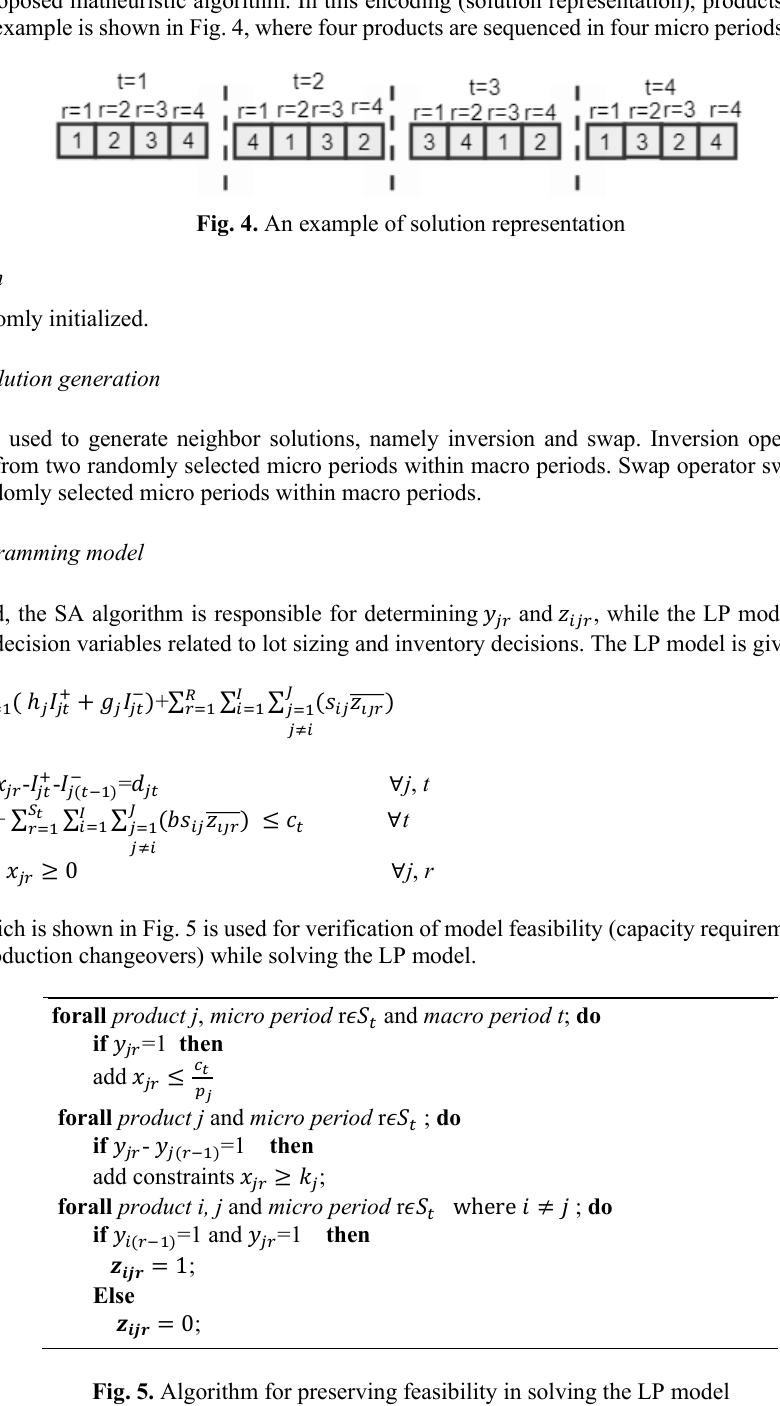
Fig. 5. Algorithm for preserving feasibility in solving the LP